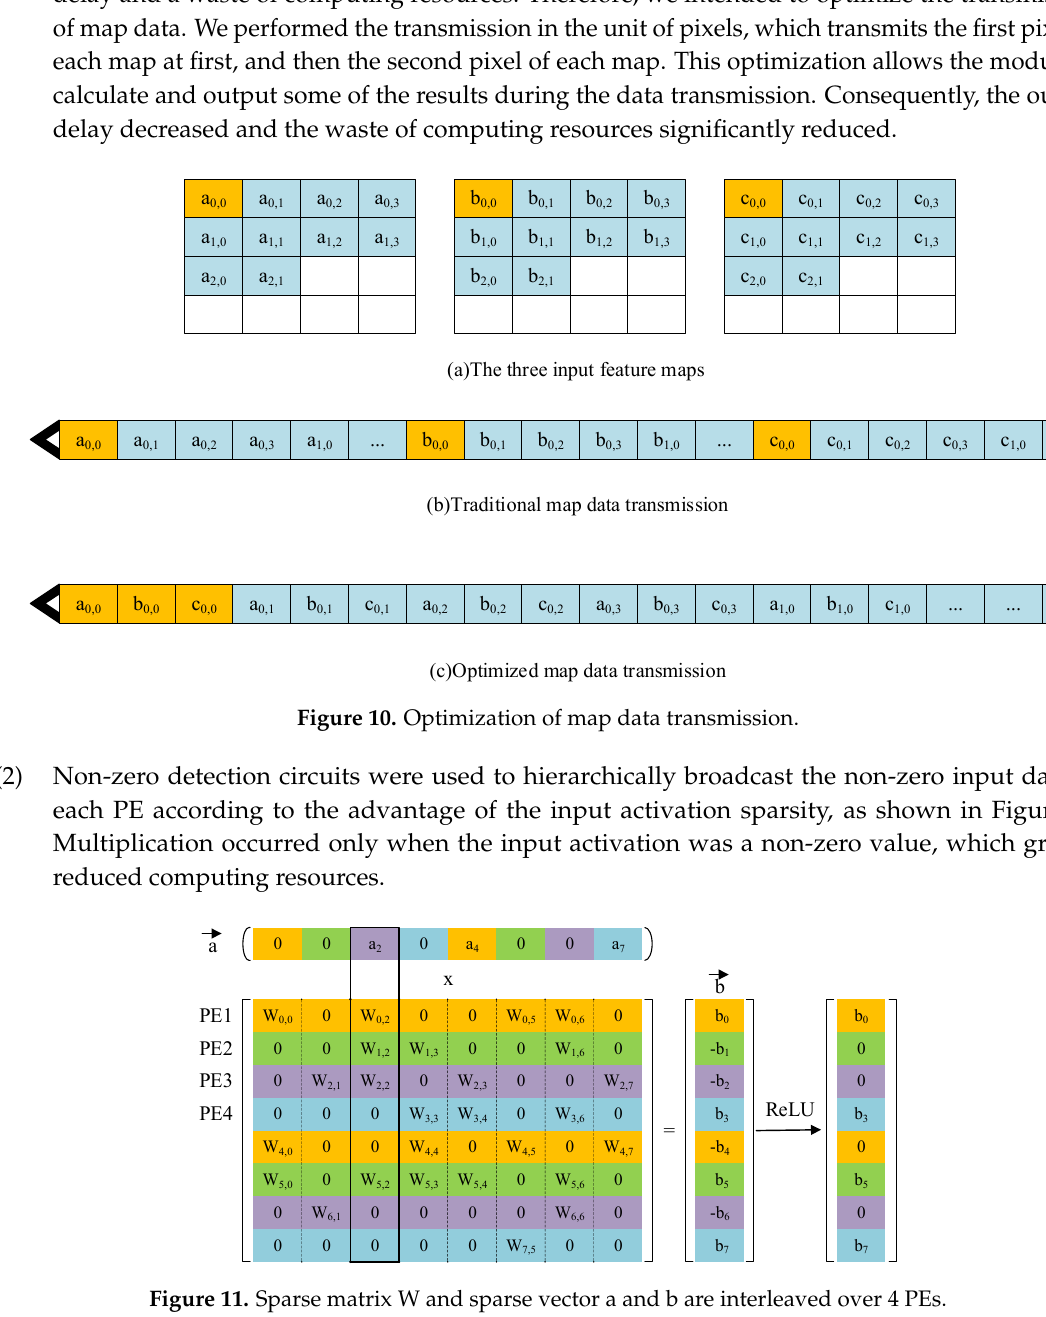
Figure 9. The hardware-PE. ReLU: rectified linear unit.